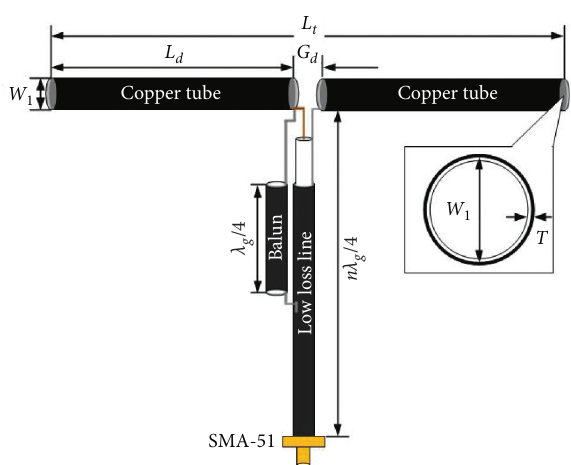
Figure 12: The geometry of dipole antenna. Table 2: Dipole antenna